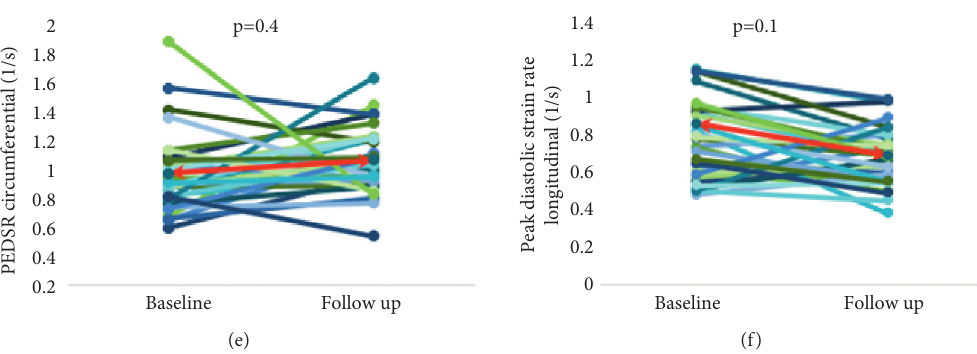
Figure 4: Comparison of imaging parameters at baseline and follow-up. Comparison between the left ventricular end-diastolic volume (LVEDV), right ventricular end-diastolic volume (RVEDV), left ventricular ejection fraction (LVEF), right ventricular ejection fraction (RVEF), peak diastolic strain rate (PEDSR) circumferential and PEDSR longitudinal at baseline, and year 6 follow-up scans (line in red indicates mean values for each variable). Table 4: Clinical and biochemical characteristics at baseline of the participants with and without MACE (angina, myocardial infarction, revascularization, and cerebrovascular accident) at follow-up.